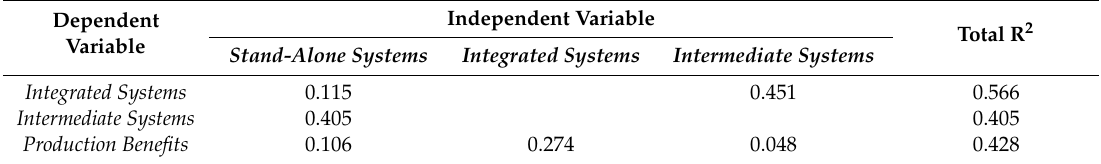
Table 8. R 2 contribution.